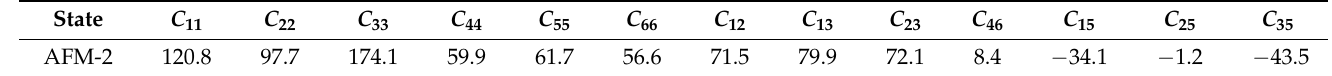
Table 5. Calculated elastic constants C ij (GPa) of α -Cu 2 P 2 O 7 .